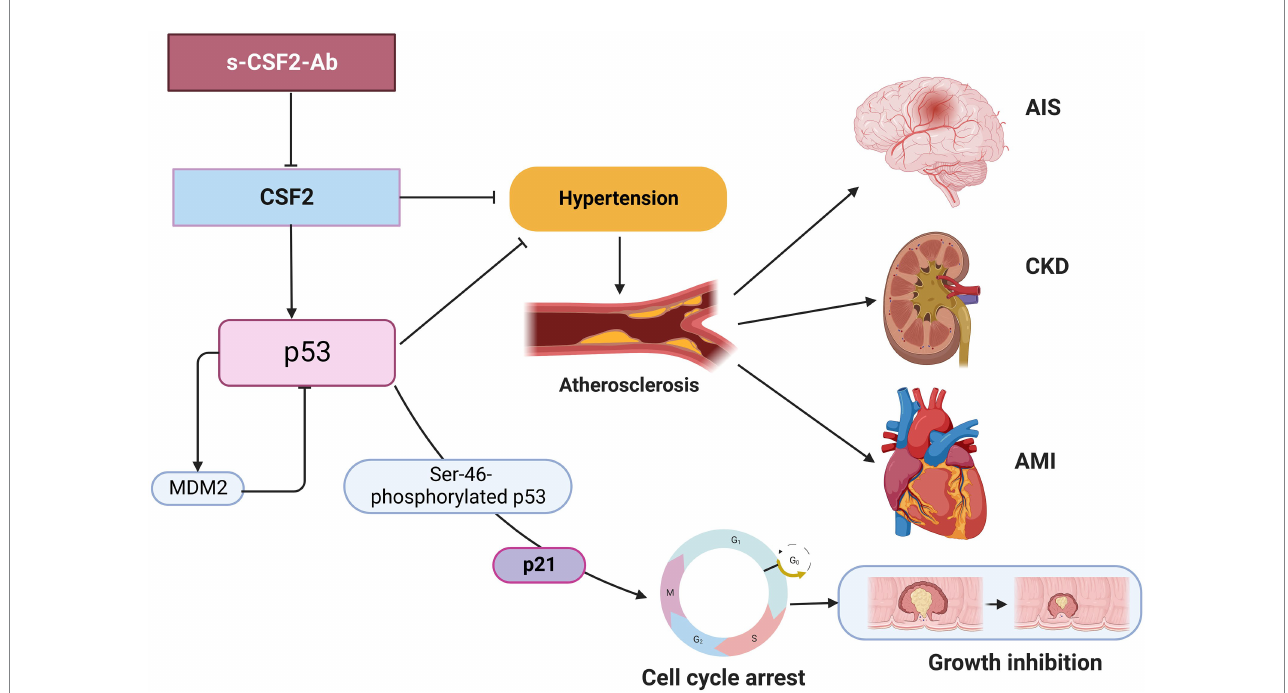
FIGURE 7 Diagram of the relationship between s-CSF2-Ab and p53 in cancer and atherosclerosis-related diseases. Arrows represent the downstream activation, and blocked arrows represent inhibitory action. Created with BioRender.com. MDM2 , mouse double minute 2